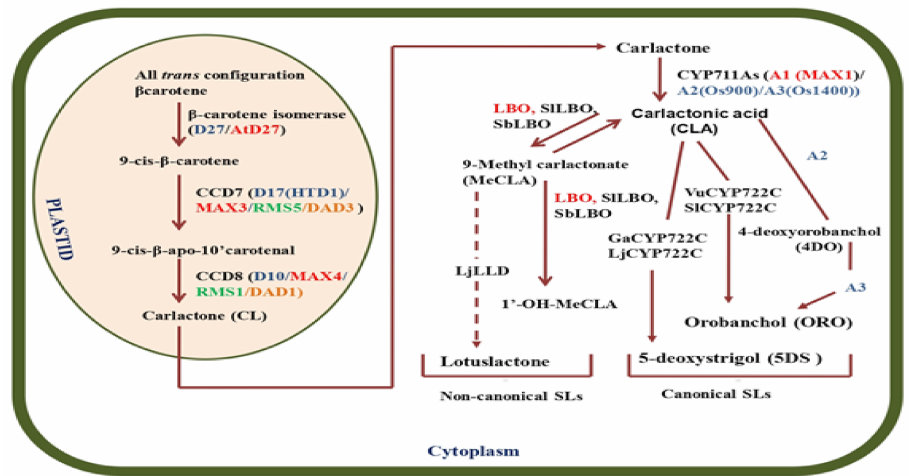
Figure 2. Strigolactone biosynthesis in a plant cell. Proposed SL biosynthesis pathway. D27, CCD7, and CCD8 are plastid localized enzymes that form CL from all- trans β -carotene. CL is then oxidized by the CYP711A family to yield CLA. GaCYP722C and LjCYP722C are involved in the production of strigol-type canonical SL, 5DS. For non-canonical SLs, MeCLA was shown to be synthesized from CLA in Arabidopsis. It has recently been demonstrated that Arabidopsis, tomato, and sorghum LBOs convert MeCLA into 1-OH-MeCLA and CLA. Moreover, LjLLD, encoding a novel 2OGD, was shown to be involved in the biosynthesis of lotuslactone (non-canonical SL). Enzymes of rice, Arabidopsis, pea, petunia, and other plants are shown in blue, red, green, and orange, respectively. Solid arrows indicate the confirmed pathways, whereas dashed arrows indicate the pathways which are not fully established. LBO (LATERAL BRANCHING OXIDOREDUCTASE) Vu, Vigna unguiculata (cowpea); Sl, Solanum lycopersicum (tomato); Ga, Gossypium arboreum (cotton); Lj, Lotus japonicus ; Sb, Sorghum bicolor